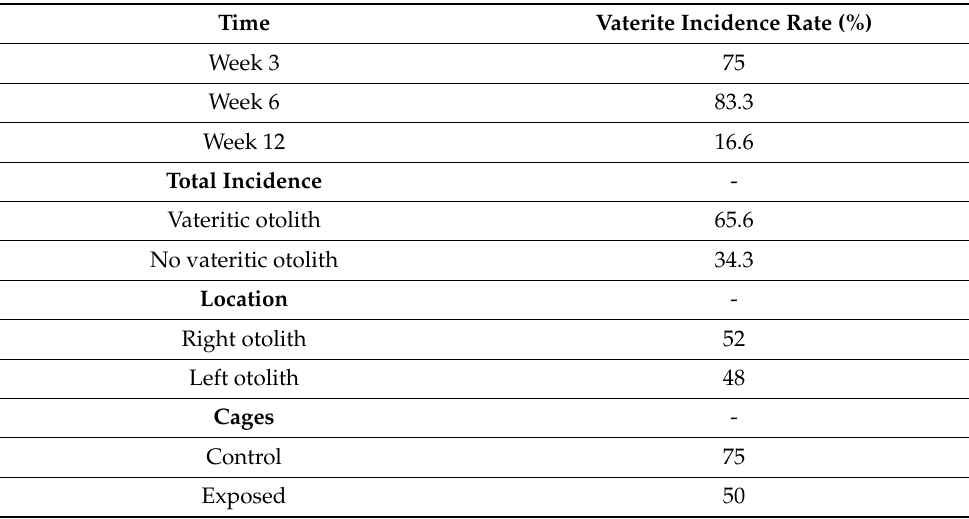
Table 1. Vaterite incidence rate on the salmon otoliths